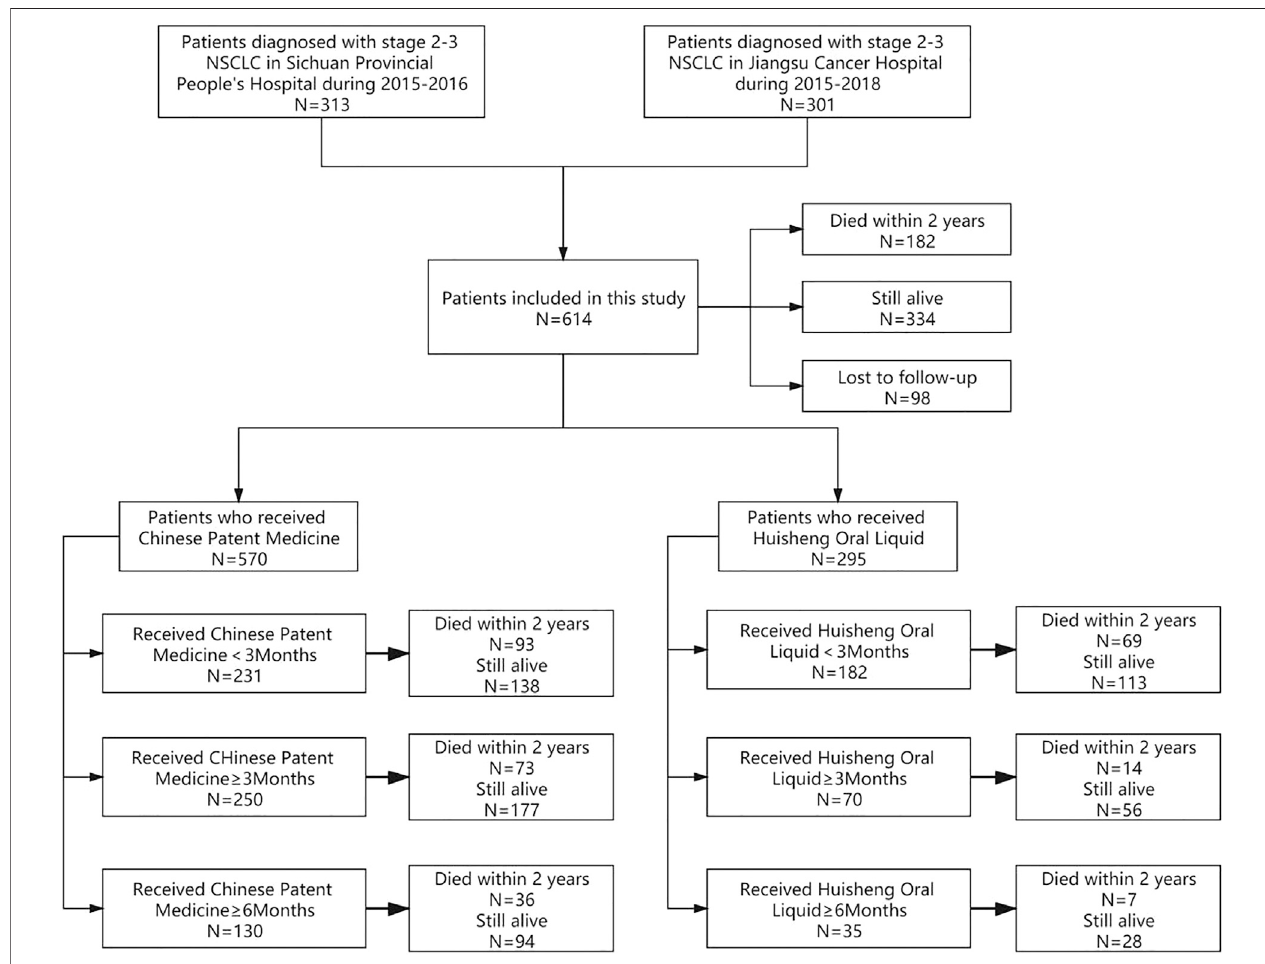
FIGURE 1 | Study group